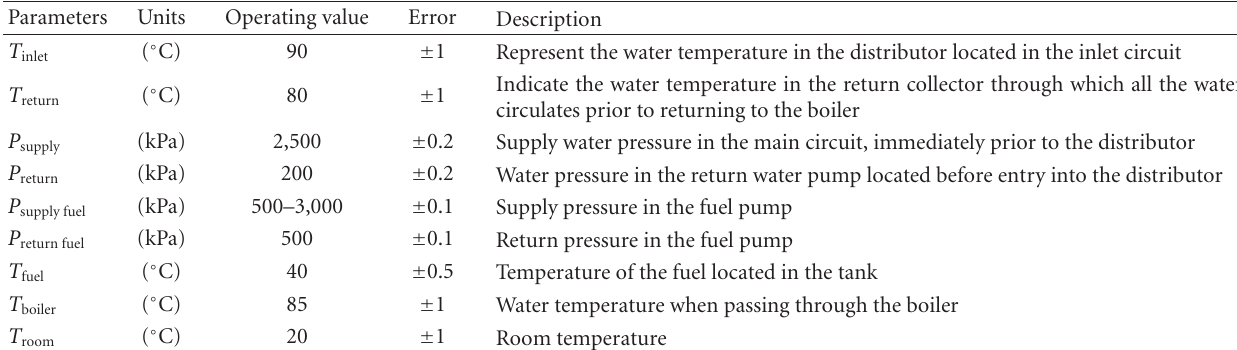
Table 6: Control parameters in the facility.